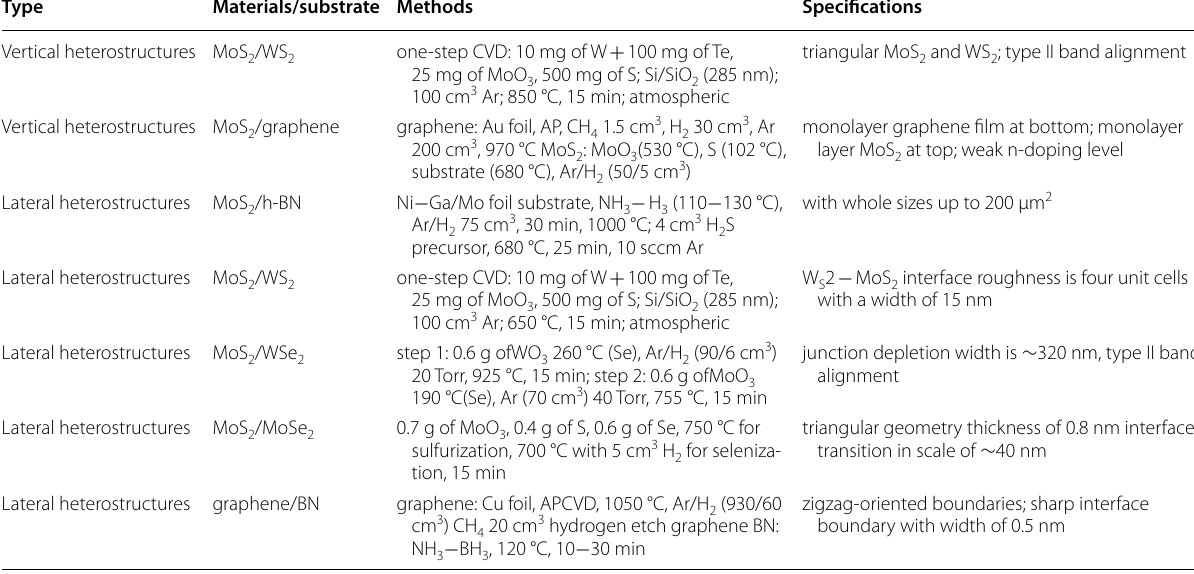
Table 1 Growth of 2D heterostructured films via CVD. Reprinted with permission from [93] Type Materials/substrate